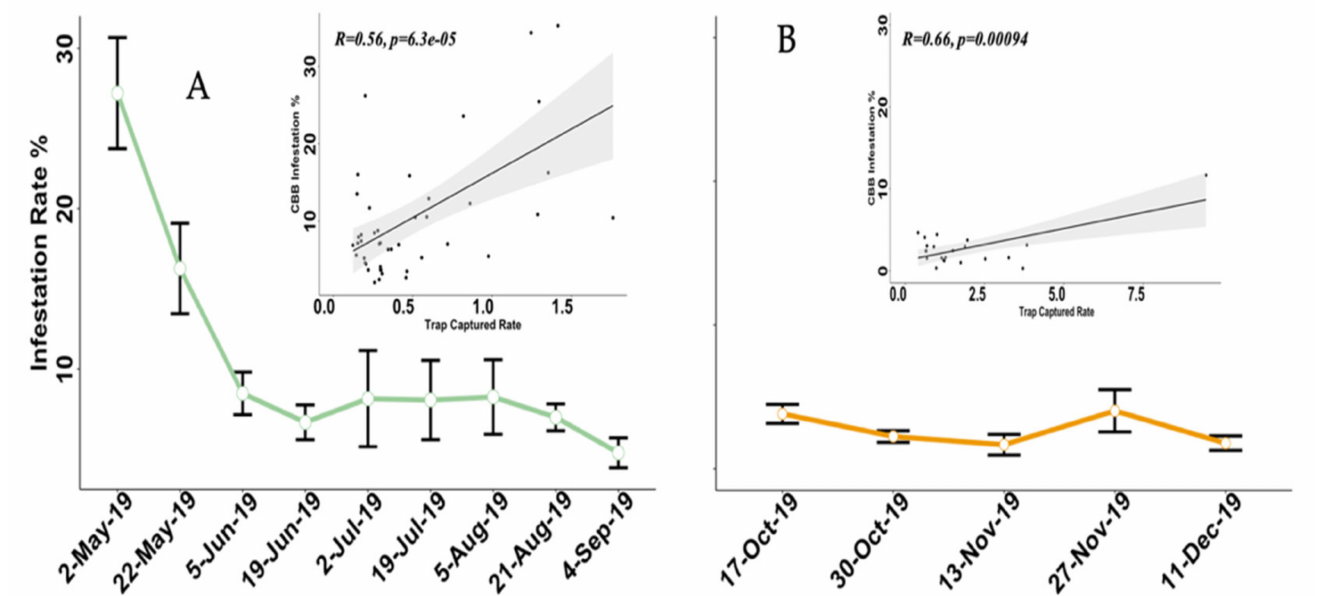
Figure 4. Plots of the average and standard error (vertical bar) of the infestation rate during experiments ( A ) and ( B ). The regression analysis shows a significant positive correlation between the percentage of infestation and trap capture. Experiment A was conducted from March 2019 to September 2019, and B was performed from October 2019 to March 2020, in Adjuntas, Puerto